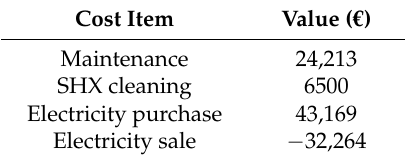
Table 5. OPEX and annual benefit of the DHC